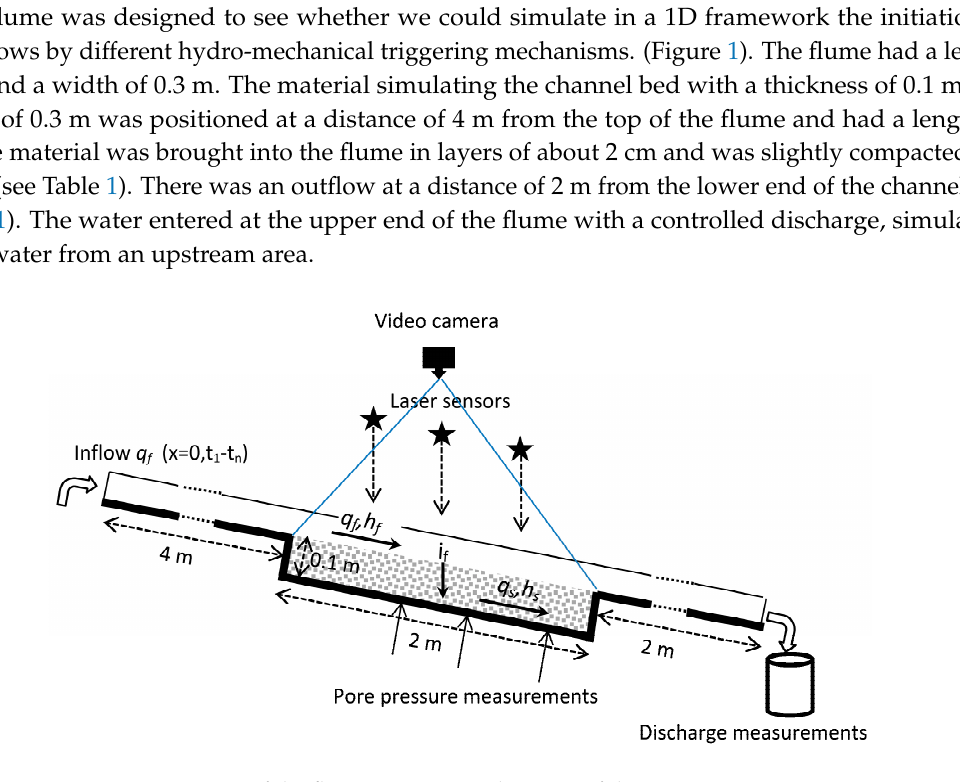
Figure 1. Design of the flume test. For explanation of the parameters see text. Table 1. Hydro-mechanical characteristics of three types of bed material used in the flume tests. Friction means friction angle of the material in degrees. D30/50 means that 30/50% of the sample had a lower diameter than what is indicated in the column.